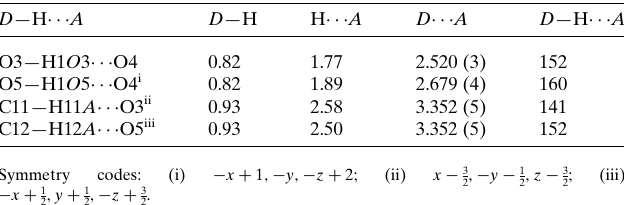
Table 1 Hydrogen-bond geometry (A˚ , (cid:5) ).